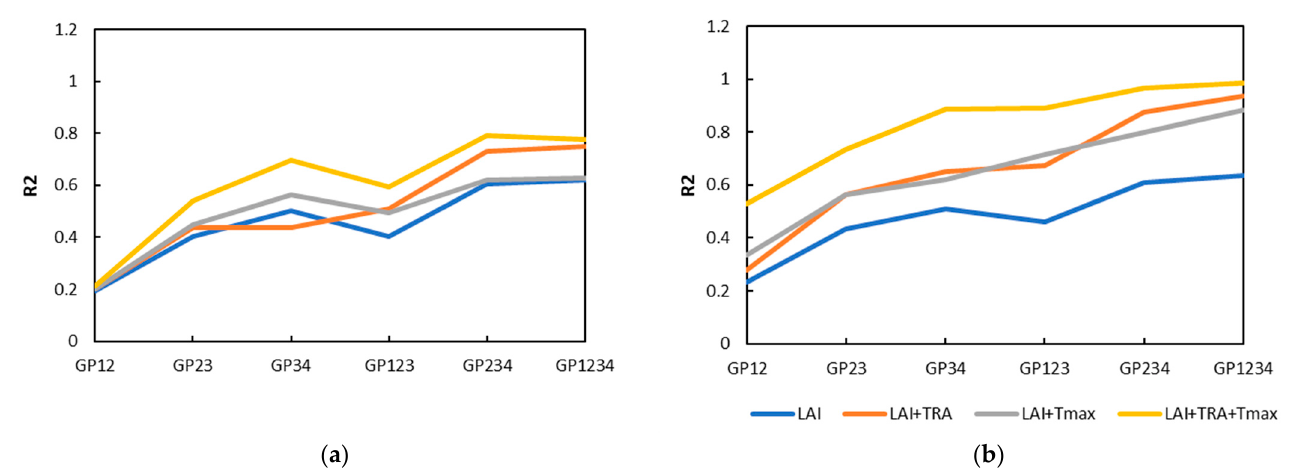
Figure 10. R 2 of yield forecast models under different input variable combinations. ( a ) R 2 of RF models; ( b ) R 2 of GRU models.